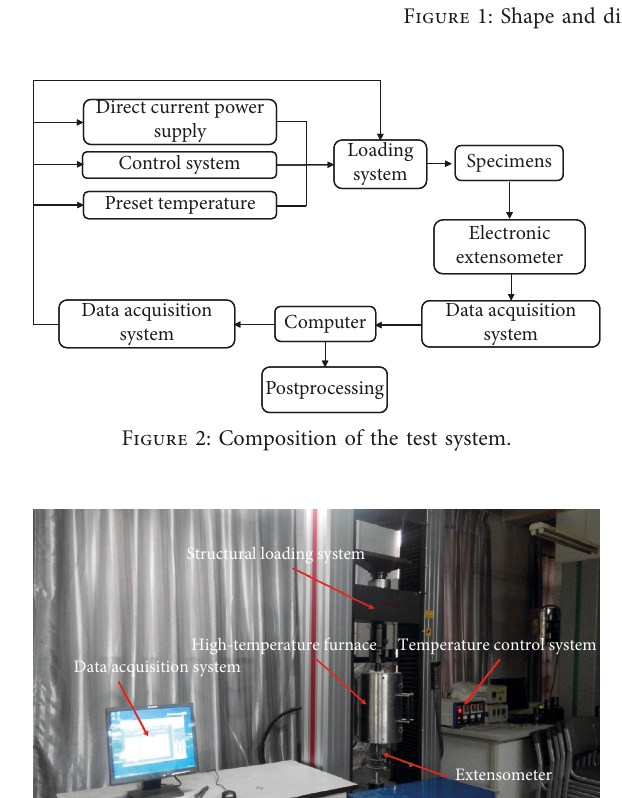
Figure 1: Shape and dimensions of the specimens.